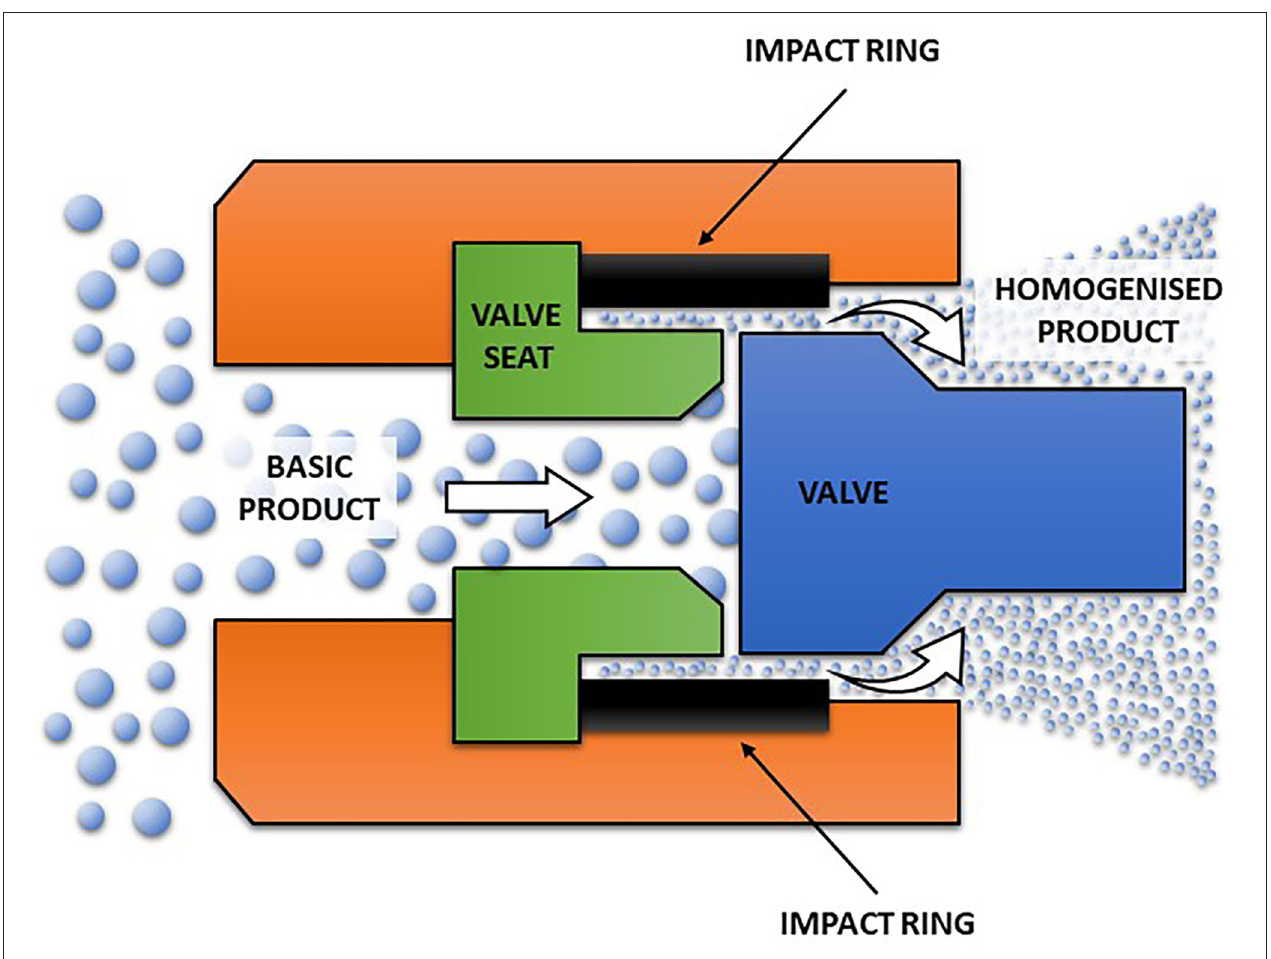
FIGURE 2 | Schematic diagram a simple flow path for homogenizing valve of high-pressure homogenization